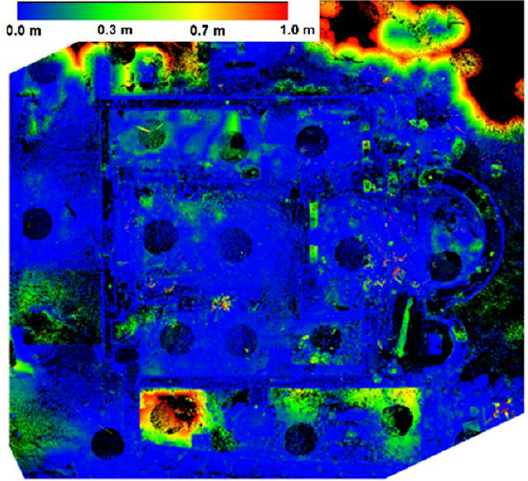
Figure 4: Cloud to cloud distance between point clouds acquired in 2015 and in 2017.